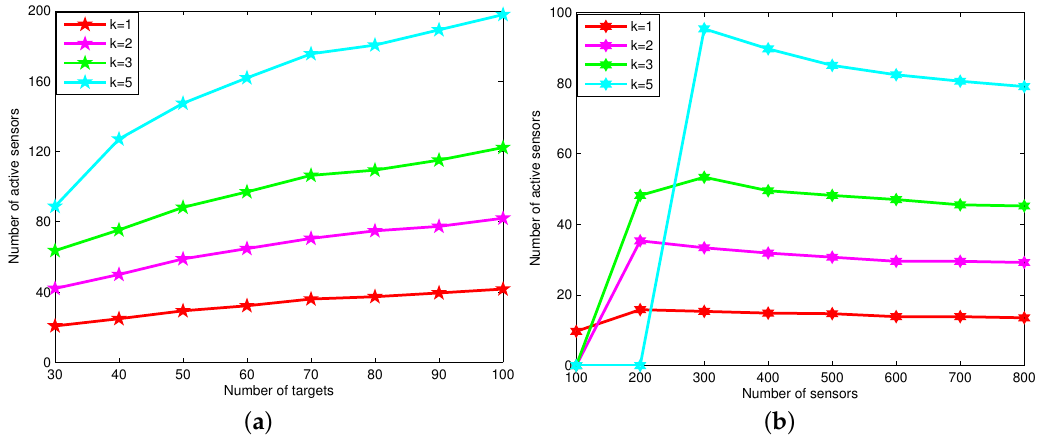
Figure 10. The average number of active nodes vs. the number of targets and sensor nodes. ( a ) The average number of active nodes changes when the number of targets changes; ( b ) the average number of active nodes changes when the number of sensor nodes changes.